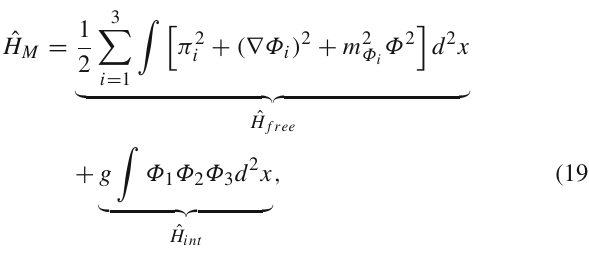
= m (η ) , where η with m Φ i h − c h − c denotes the moment i in which the high-curvature regime begins. Throughout the > m Φ + m Φ . paper we will assume that m Φ 1 2 3